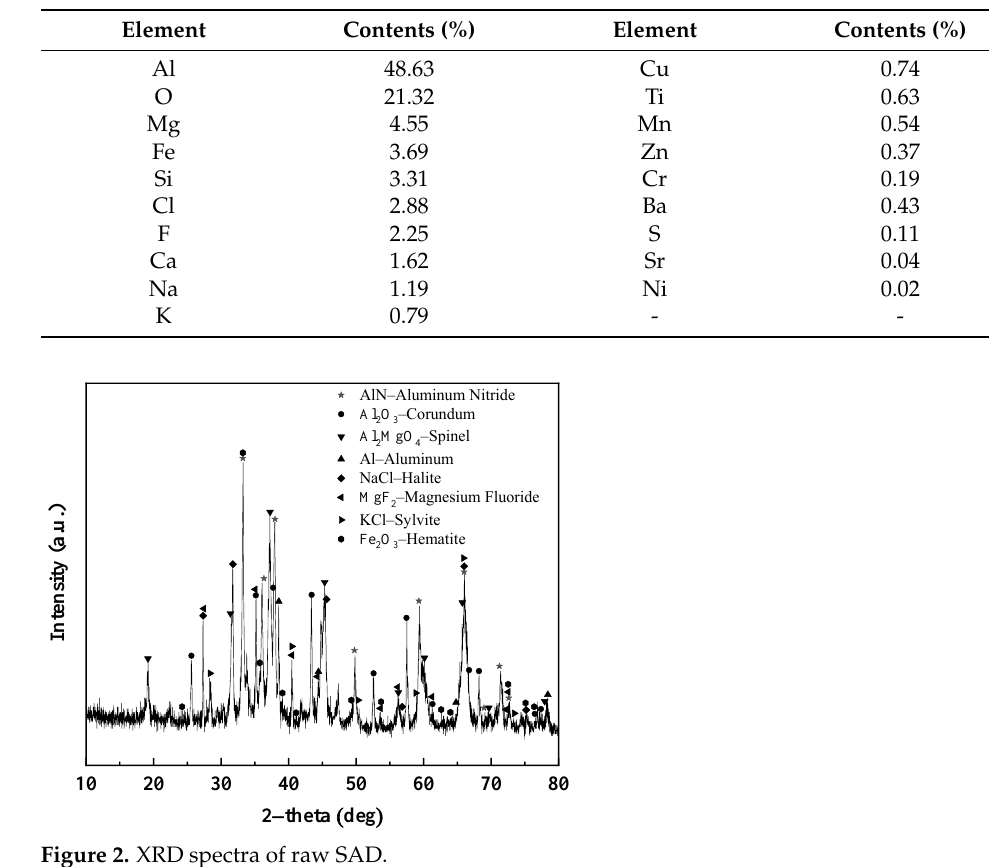
Table 1. Chemical analysis of raw SAD samples.